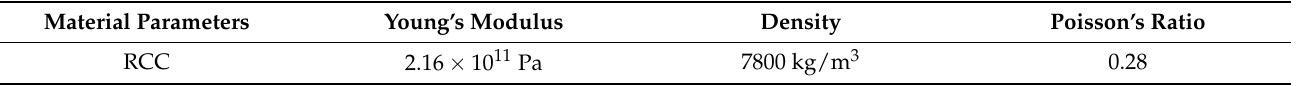
Table 2. Material parameters of RCC.